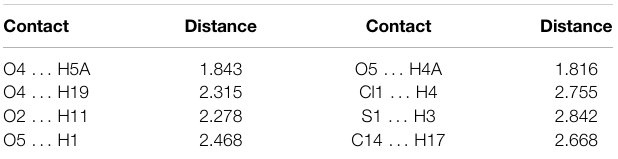
TABLE 1 | The short intermolecular contacts in 2b . Contact